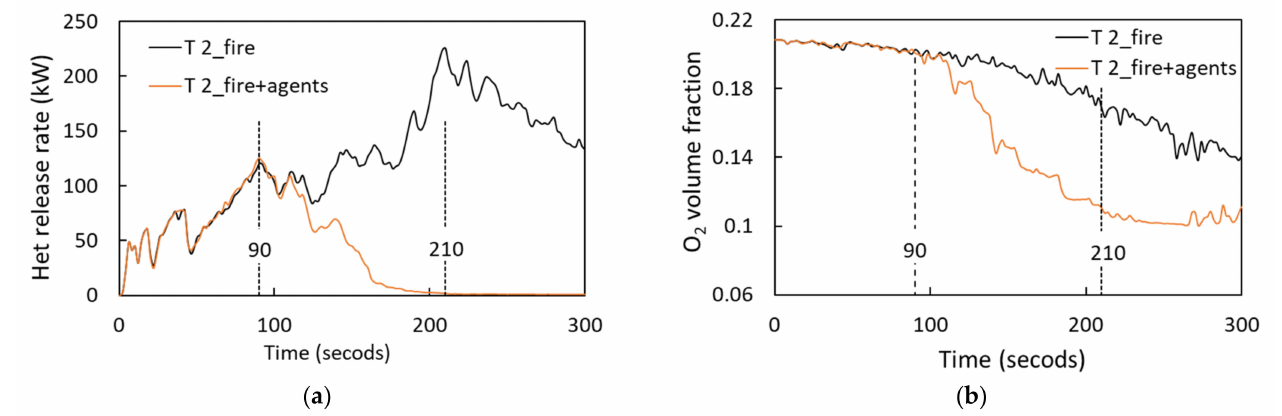
Figure 9. ( a ) Heat release rate and ( b ) oxygen volume fraction in the center of the top closet for simulation cases T2_fire and